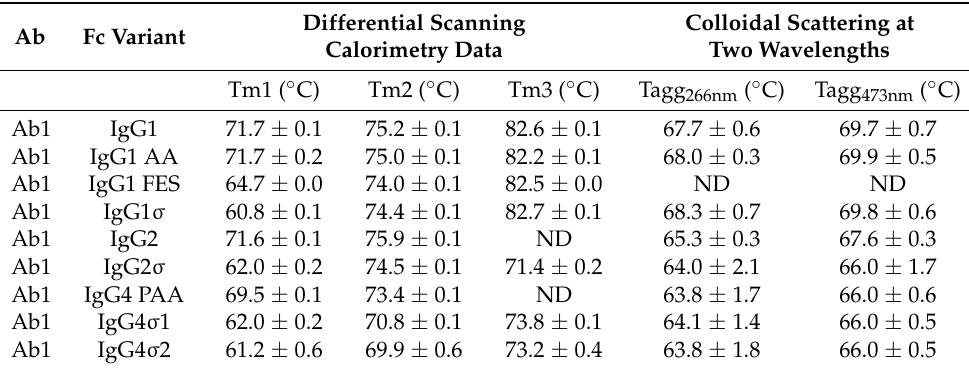
Table 2. Thermal stability of the Fc variant antibody